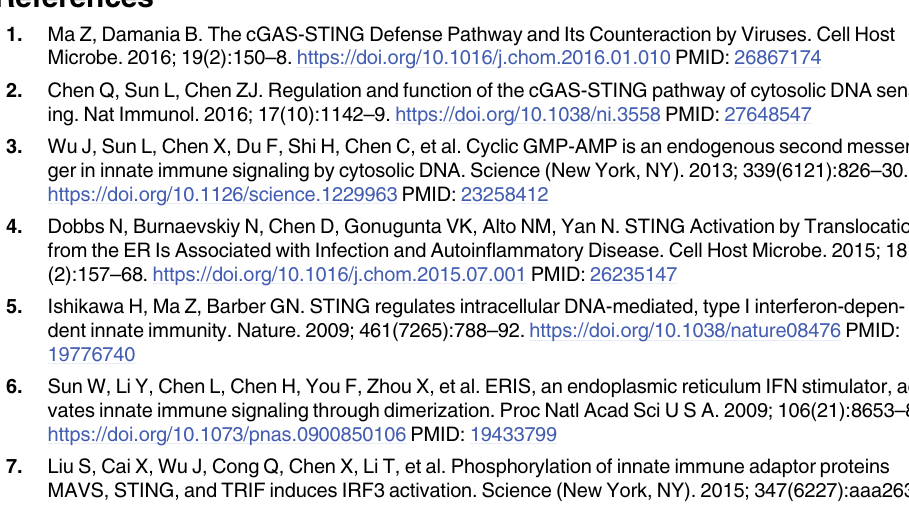
Isg15 , Oas1b ) mRNA expression in WT and RNF5-deficient MEFs infected with PRV-WT (MOI = 1) for the indicated times. (F) Cumulative results for densitometric quantitation of indicated proteins (above) in Fig 6E as normalized to the levels of β -actin loading control. (G) qPCR analysis of Ifnar mRNA in wild type (WT) and IFNAR-deficient (IFNAR KO) BMDMs. (H, I) qPCR analysis of gD gene expression in IFNAR-deficient BMDMs (H) or STING-defi- cient PK-15 cells (I) infected with PRV-WT or PRV- Δ UL13 (MOI = 1) for indicated times. Data are representative of one experiment (A, B, D, G) or pooled from three independent experiments (C, E, F, H, I, mean ± SD). � p < 0.05, �� p < 0.01 and ��� p < 0.001, ns, not signifi- cant (Student’s t test). (EPS) S1 Table. Primers used in this study.